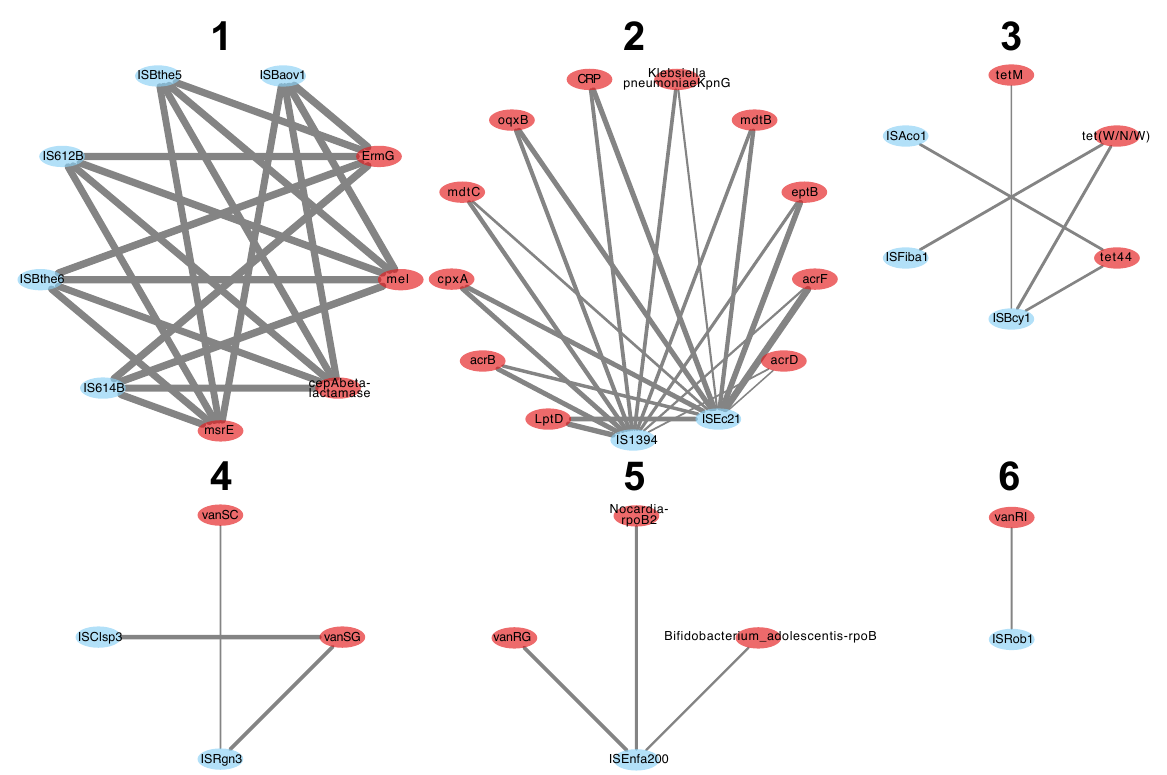
Figure 3. Correlations between ARGs (red) and ISs (blue). The six clusters are numbered from 1 to 6. The thickness of the lines reflects the strength of the correlations between the